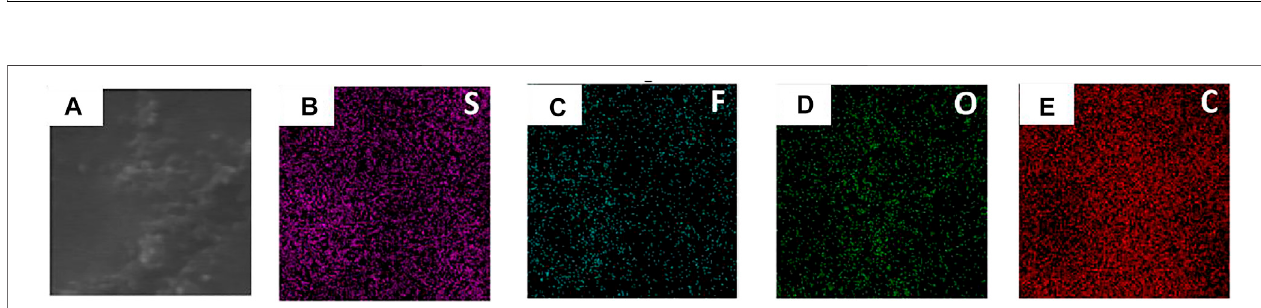
FIGURE 2 | SEM and EDS mapping of the bottom surface of the fl exible asymmetric organic-inorganic composite solid-state electrolyte. (A) SEM image, (B) EDS mapping image of S, (C) F, (D) O, (E) C.